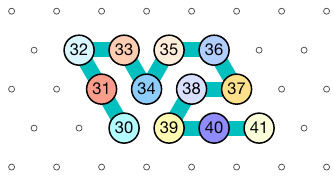
Figure 4. A configuration encoded by 30 NW Ô 31 NW Ô 32 Ñ E 33 Œ SE 34 NE Õ 35 Ñ E 36 Œ SE 37 Ð W 38 Ö SW 39 Ñ E 40 Ñ E